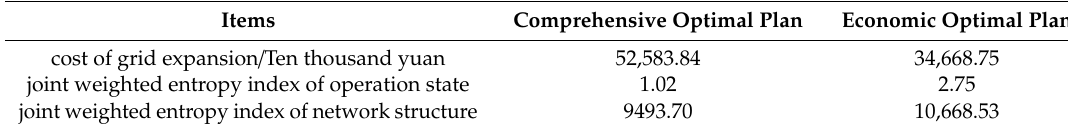
Table 2. Objective value for optimal grid planning